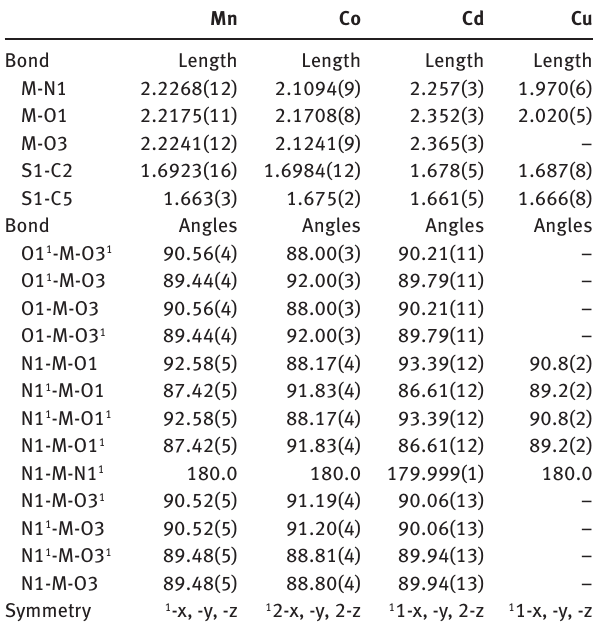
Table 2 Selected distances (Å) and angles ( ° ) of the complexes.